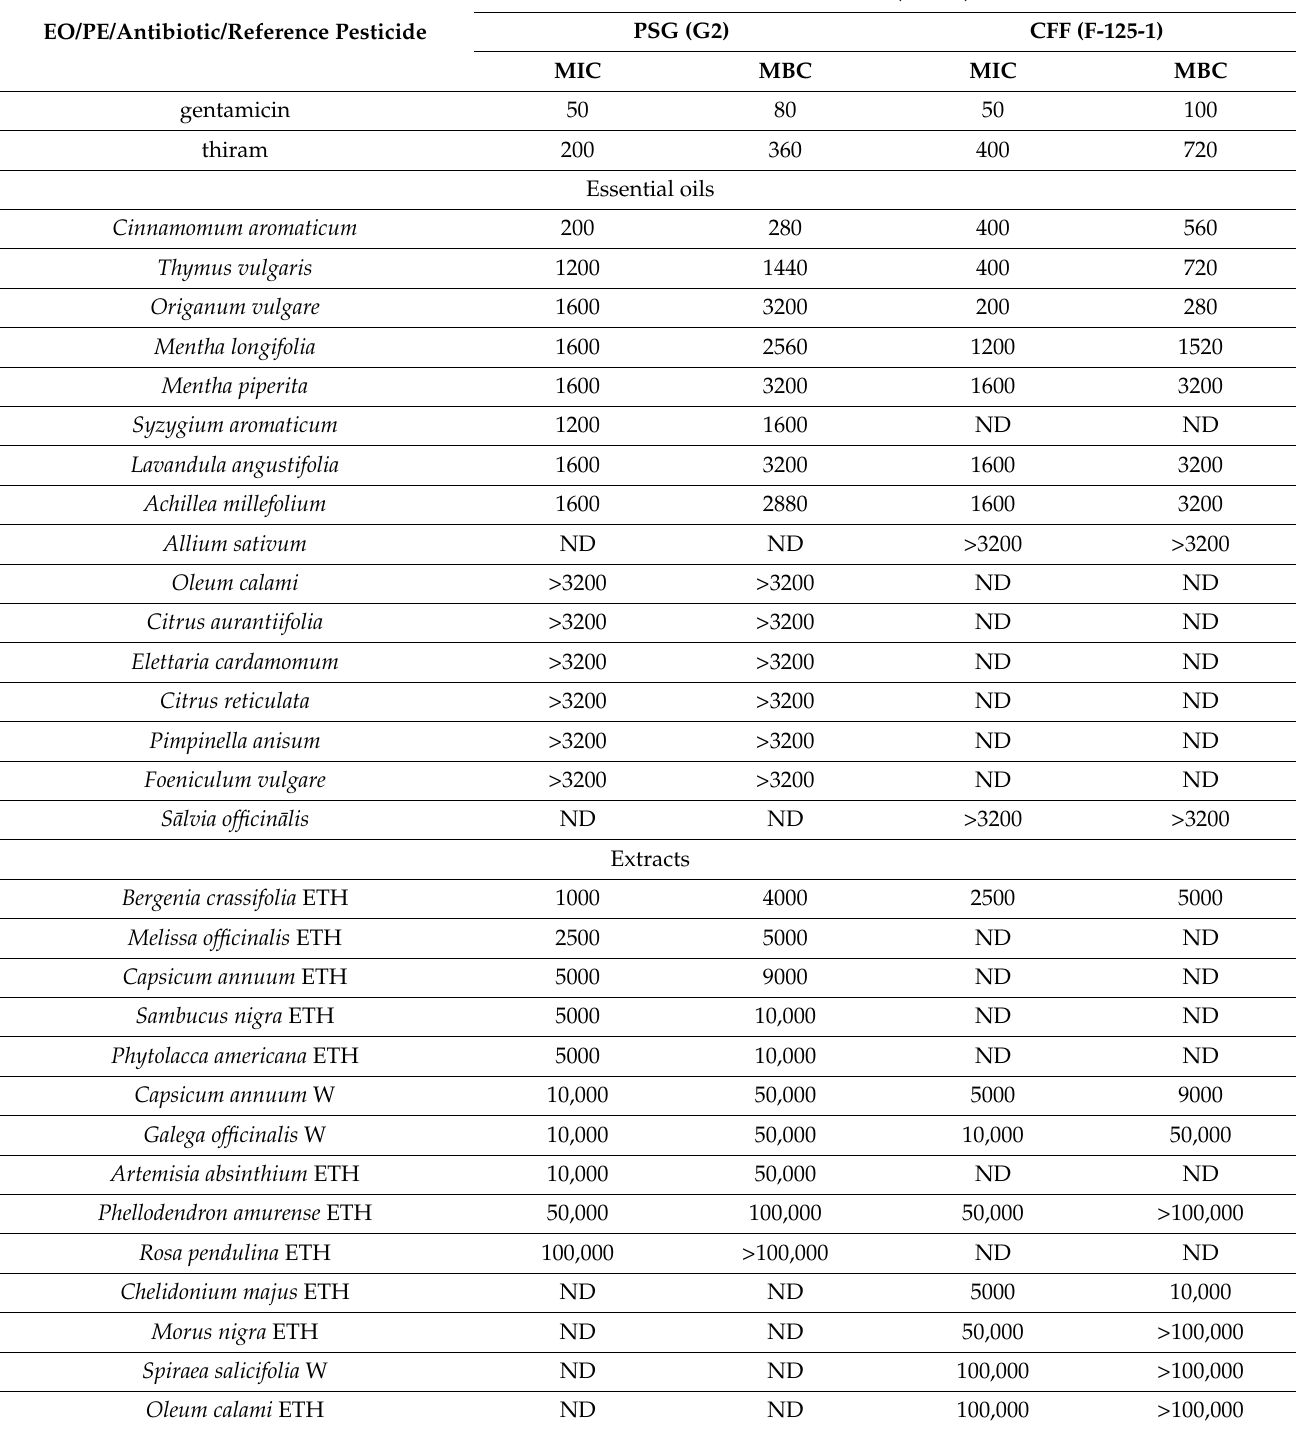
Table 1. MIC (minimal inhibitory concentration) and MBC (minimal bactericidal concentration, calculated for each substance/bacteria pair) values. MIC values were calculated by counting the bacterium concentration (CFU/mL) after culturing in a liquid medium with each substance. ND—not determined (MIC and MBC values were determined only for EO/PE that showed activity on